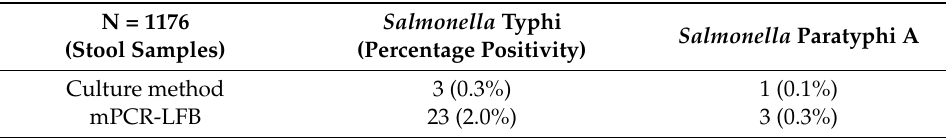
Table 3. Summary of mPCR-LFB and culture method for stool samples collected from food handlers and suspected